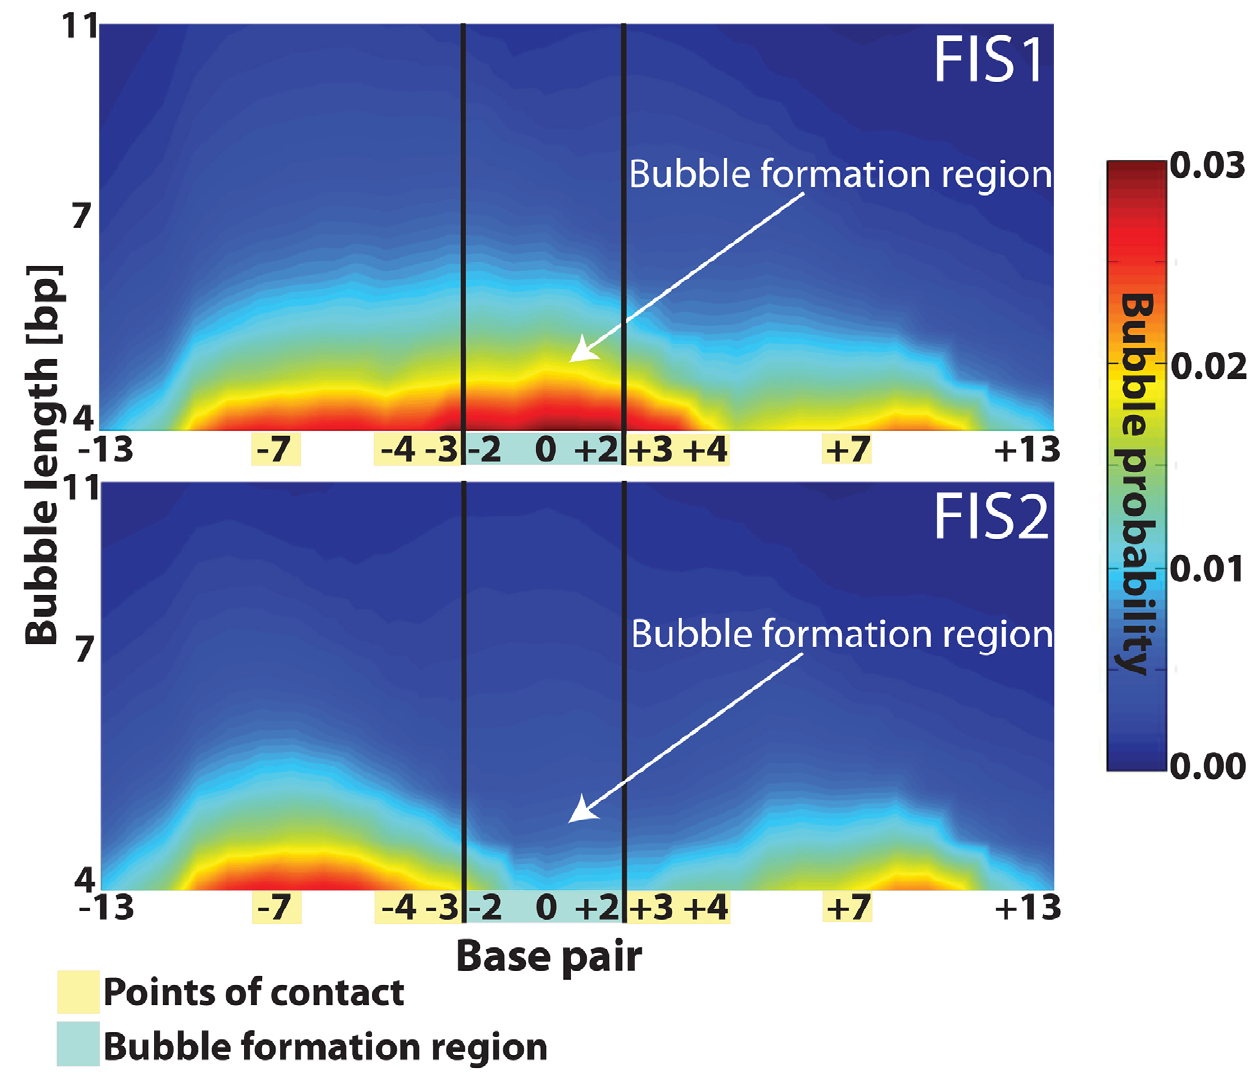
Figure 2. DNA local breathing dynamics of FIS1 and FIS2. The nucleotide positions are shown along the horizontal axis. Positions corresponding to points-of-contact are highlighted in yellow while the bubble formation region is highlighted in blue. The length of the transient bubbles (in number of base pairs [bp]) is shown along the vertical axis. The color map represents the probability for bubble openings where the red color denotes high probability and blue color denotes low probability. The name of the sequence for each variant is shown in the panel (all sequences can be found in Table 1).